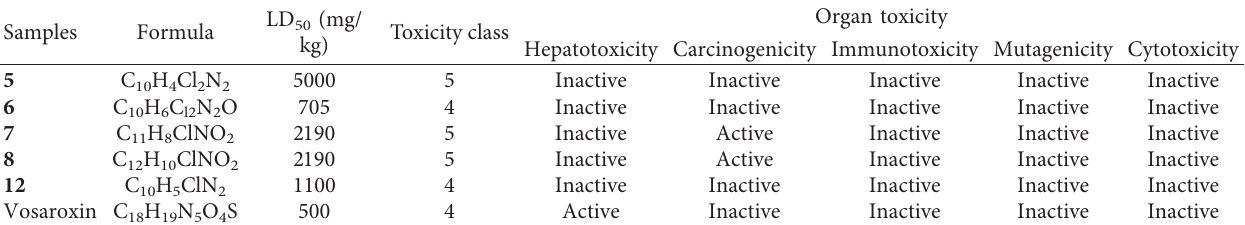
Table 7: Toxicity prediction of compounds 5 – 8 and 12 computed by ProTox II and OSIRIS Property Explorer. Samples Formula